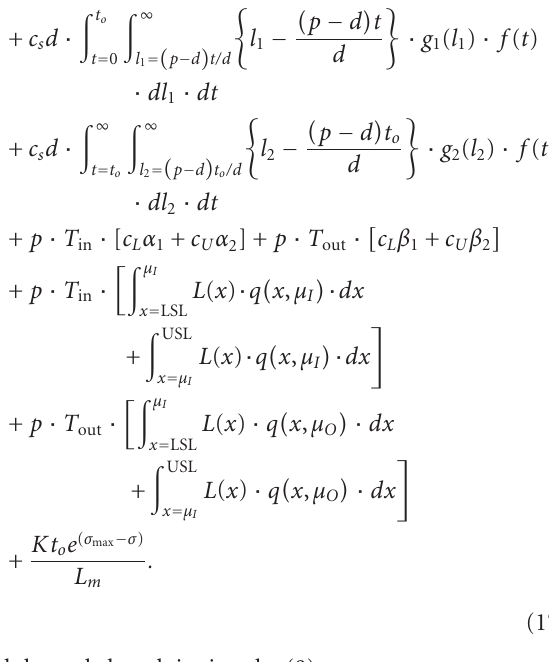
, μ ∗ , σ ∗ ) on parame- I o